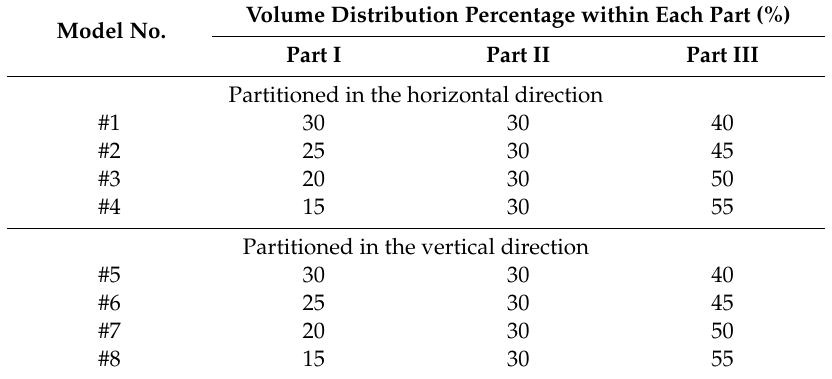
Figure 19. Aggregates distributed non-uniformly within DE models of asphalt mixtures: ( a ) aggregates distributed non-uniformly in the horizontal direction; ( b ) aggregates distributed non-uniformly in the vertical direction. Table 4. Volume distribution percentages within different parts.